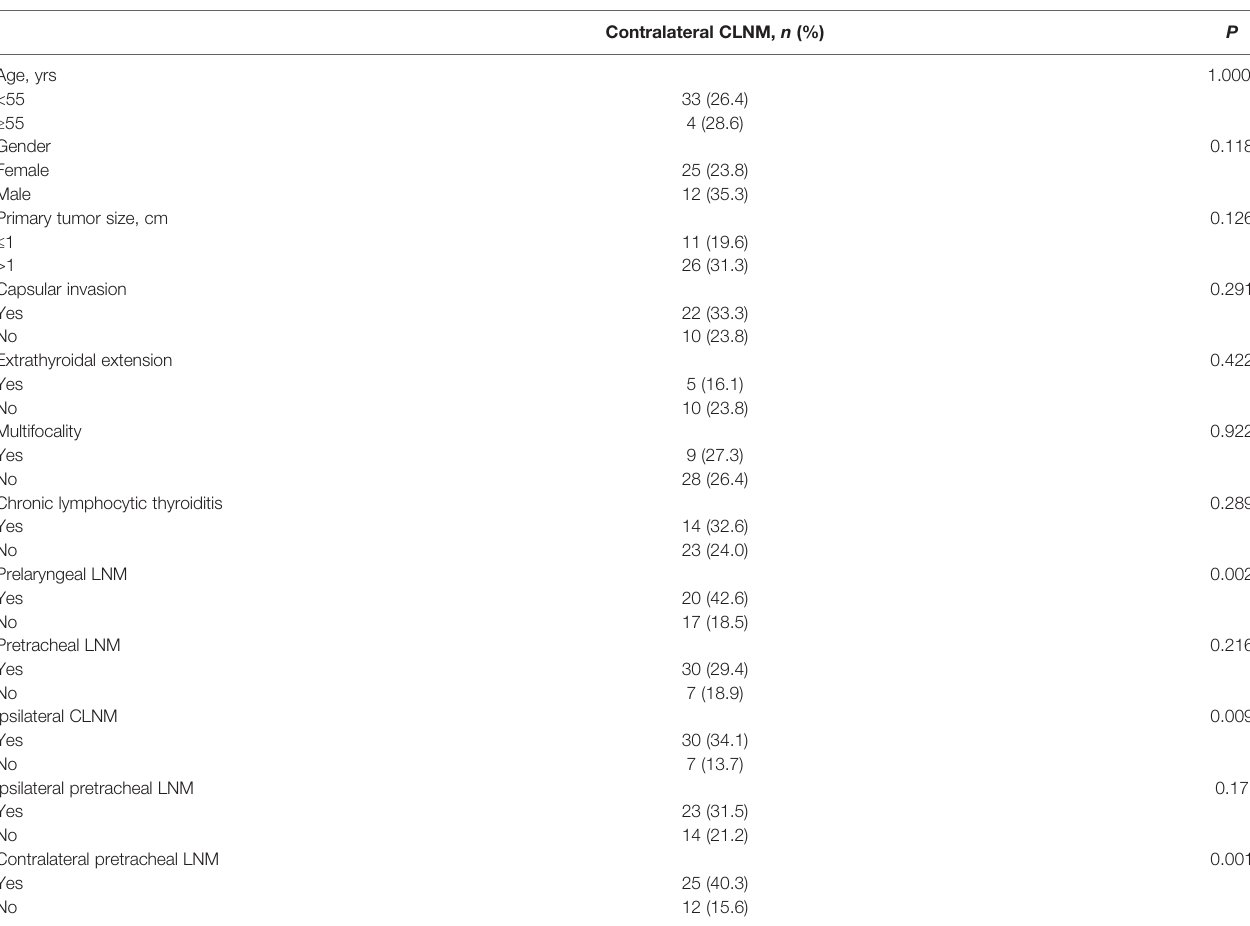
TABLE 2 | Univariate analysis of clinicopathologic characteristics for contralateral